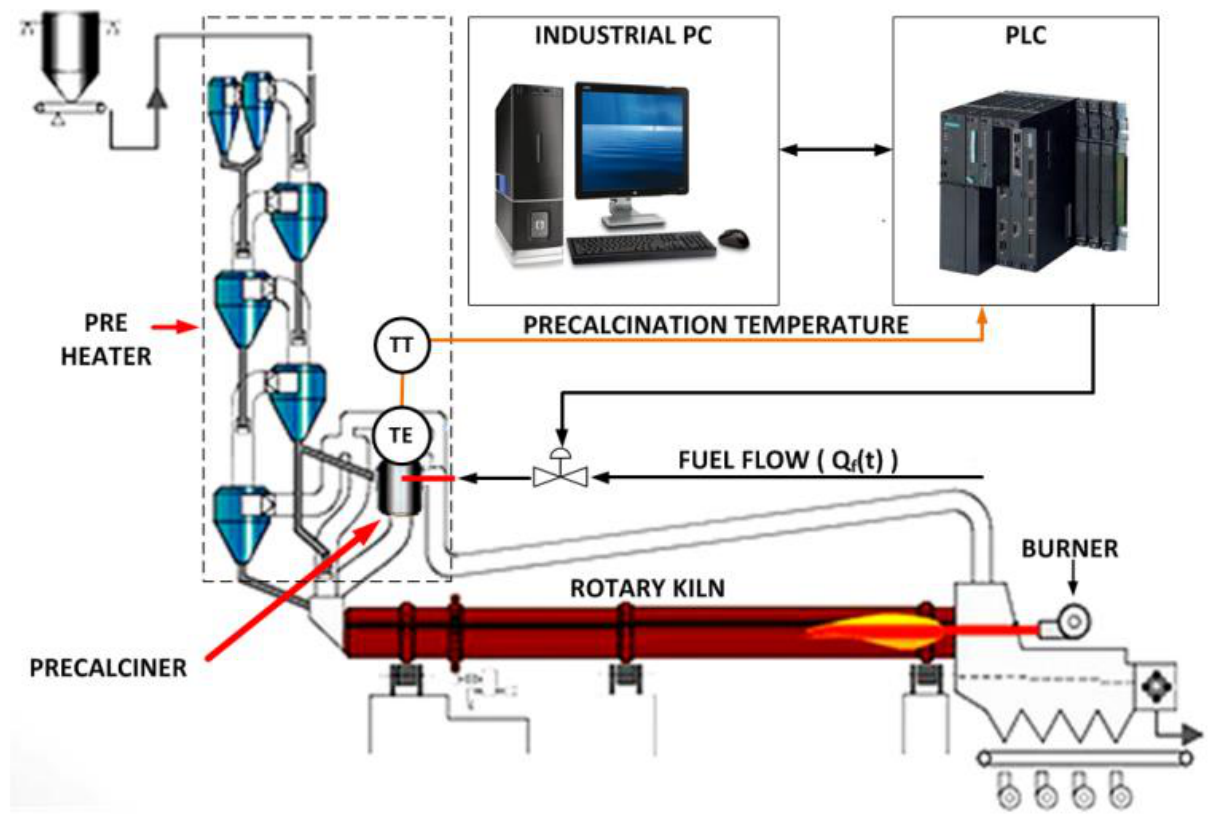
Figure 1. Diagram of the data collection in the precalciner.